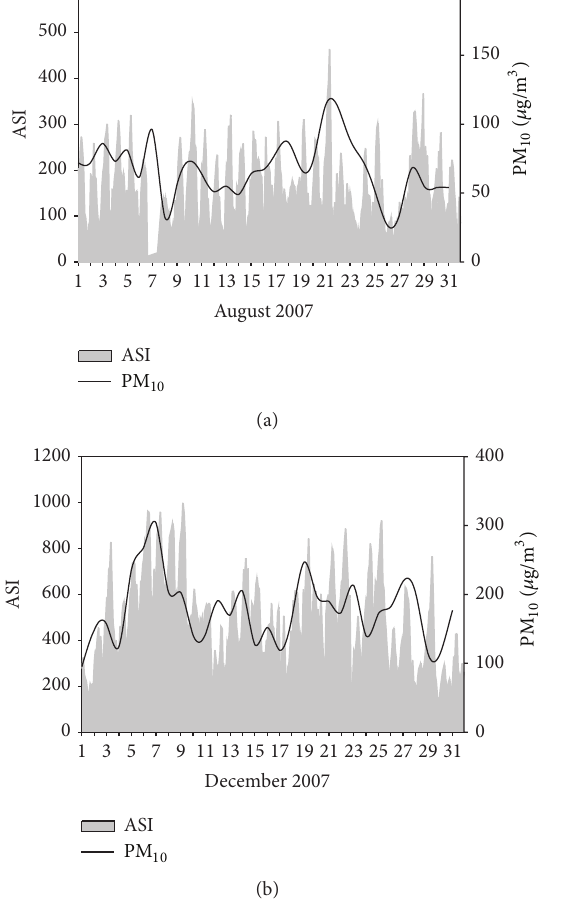
Figure 7: PM 10 and ASI (Lanzhou, China, August and December, 2007, data missing on August 6-7 for maintenance of the instru-